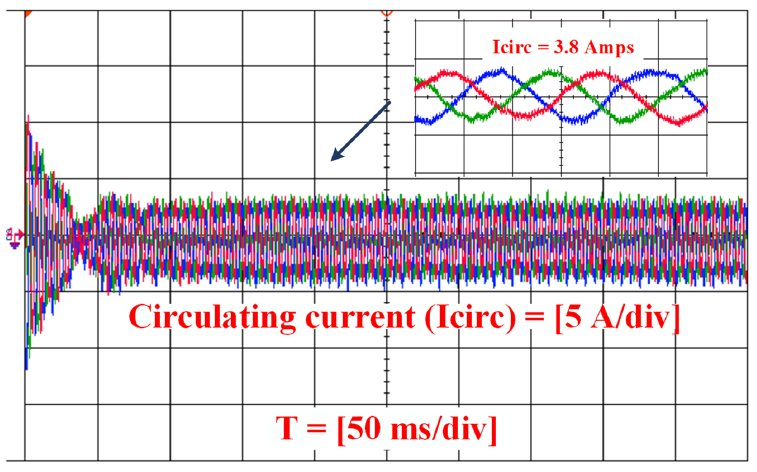
Figure 20. MMC circulating currents without controller.